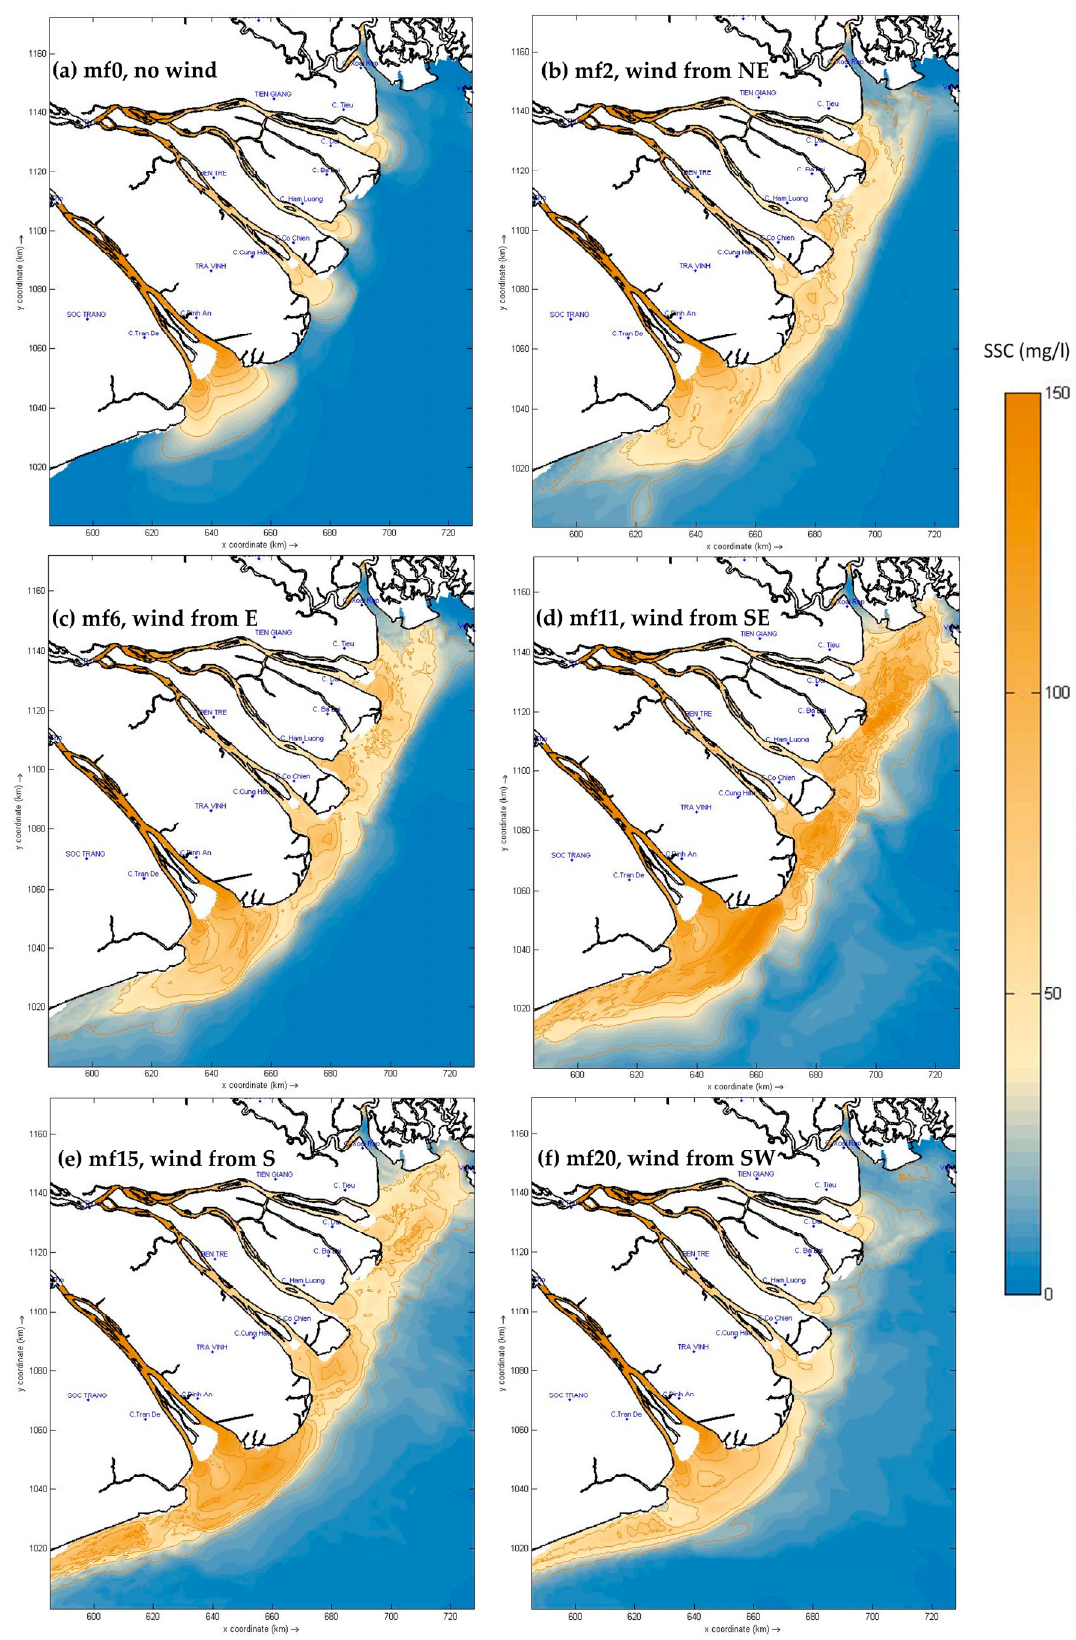
Figure 4. Distribution of suspended sediment concentration in the surface layer in the flood season in the MRD coastal area (1 h before low tide), with no wave or wave heights = 2 m from different directions.